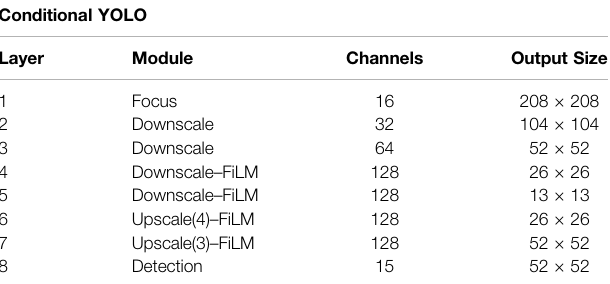
TABLE1| Theconditional YOLOarchitecture consistsoffourDownscaleandtwo Upscale blocks as depicted in Figure 4 . Upscale blocks concatenate the input from a previous layer given in parentheses, e.g.,layer 6 takes the output of layer4asadditionalinput.FiLMindicatesthattheconditionallayerisactivewithina block. The Detection layer has 15 outputs for each spatial position in the 52 × 52 output grid (5 values for each of the three anchors which are used to compute the fi nal bounding boxes (see Eq. 2 ).